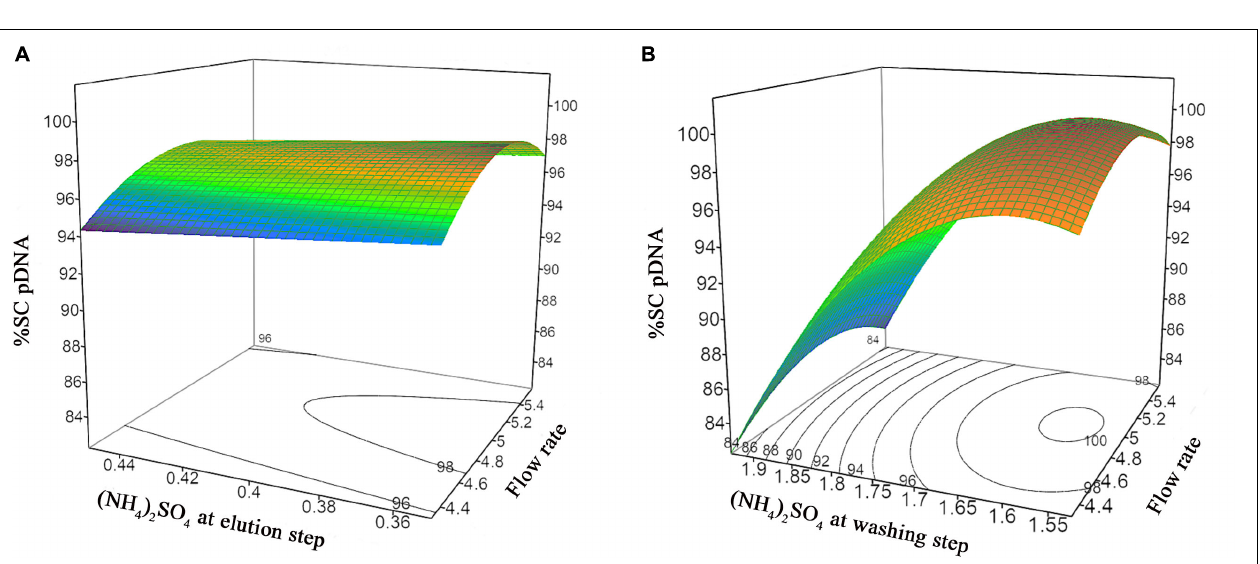
Frontiers in Bioengineering and Biotechnology |